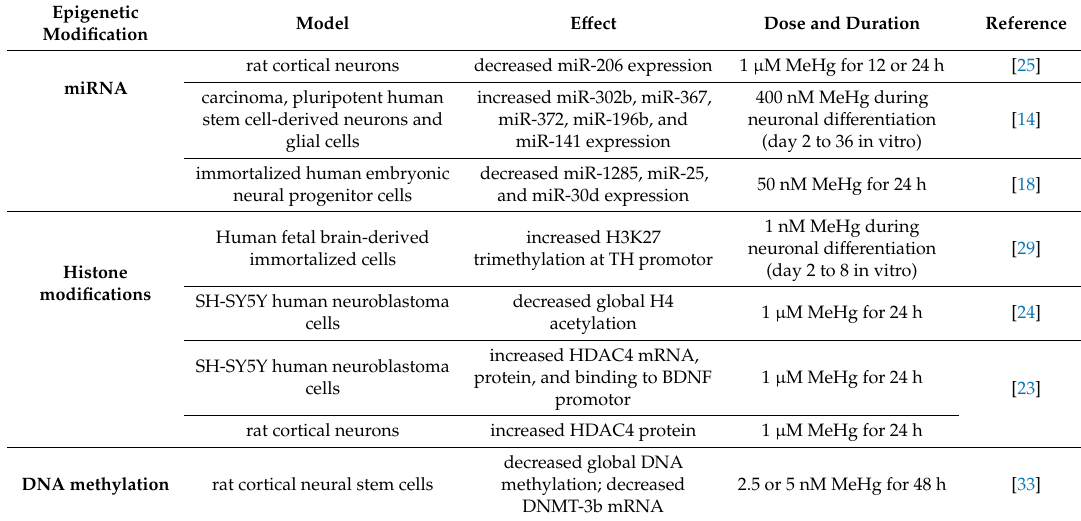
Table 1. Methylmercury-induced epigenetic modifications in